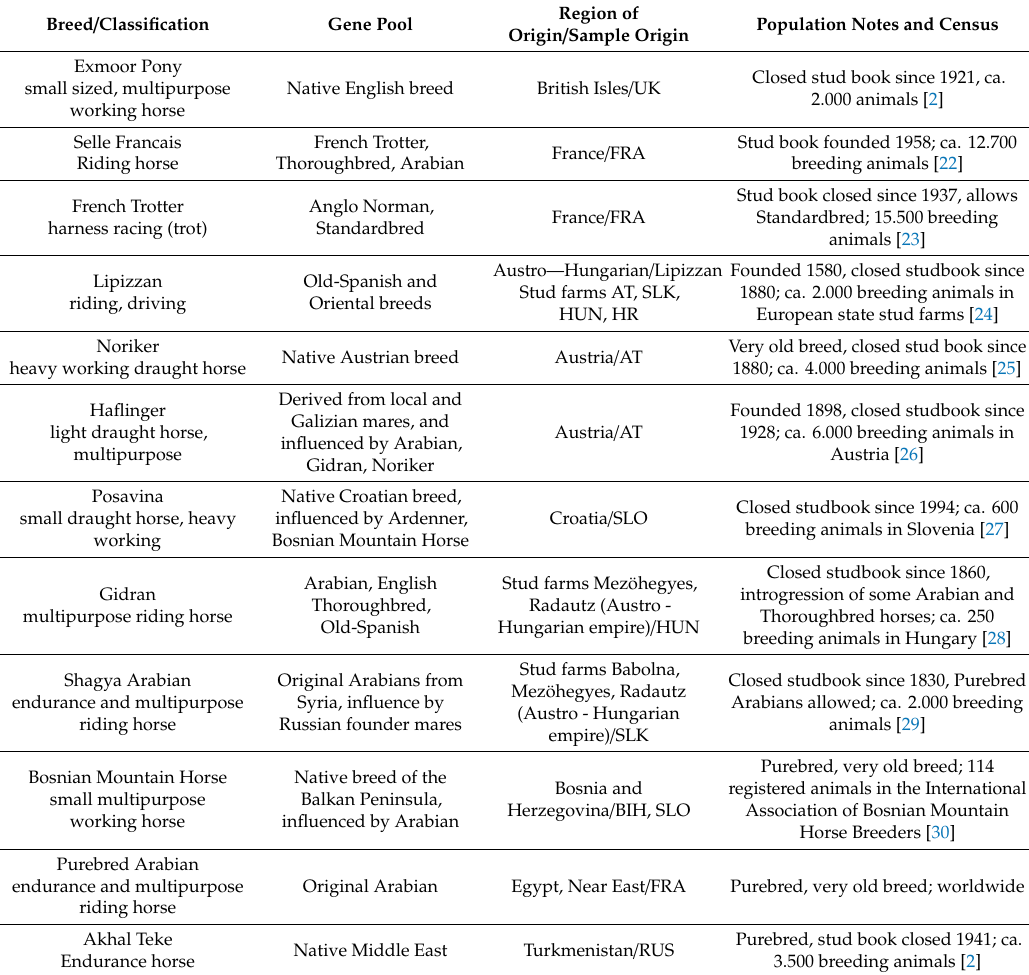
Table 1. Characterization of breeds, population history, sample location and number of sampled horses